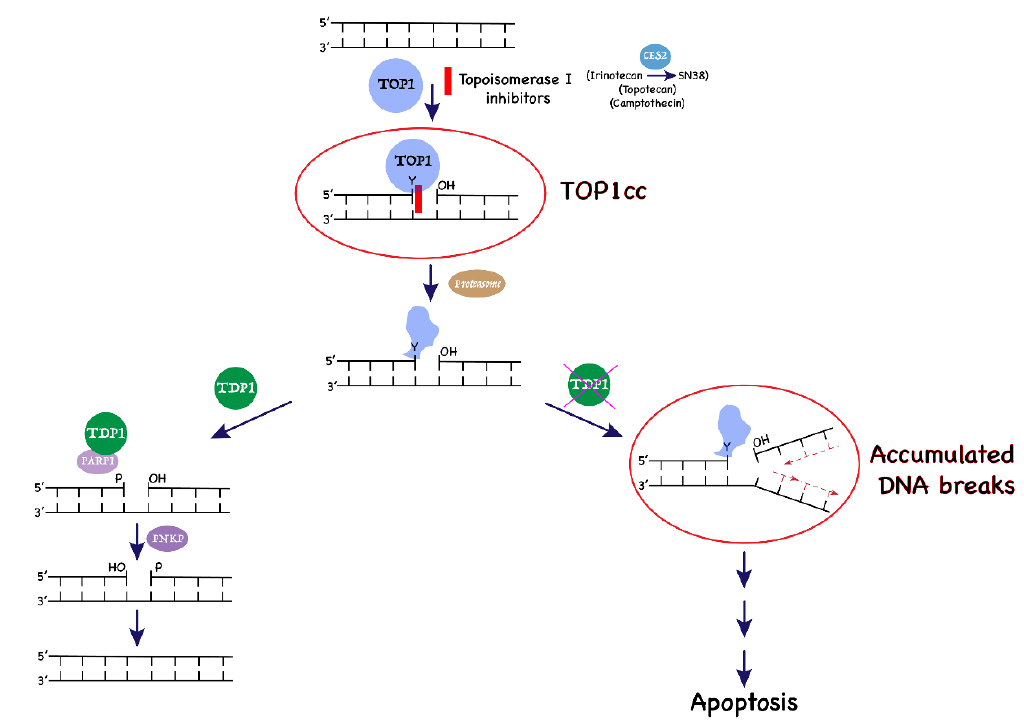
Figure 1. The action of topoisomerase I (TOP1) poison inhibitors and role of tyrosyl-DNA phosphodiesterase 1 (TDP1) in the repair of TOP1 cleavage complexes (TOP1cc) to prevent cell death.